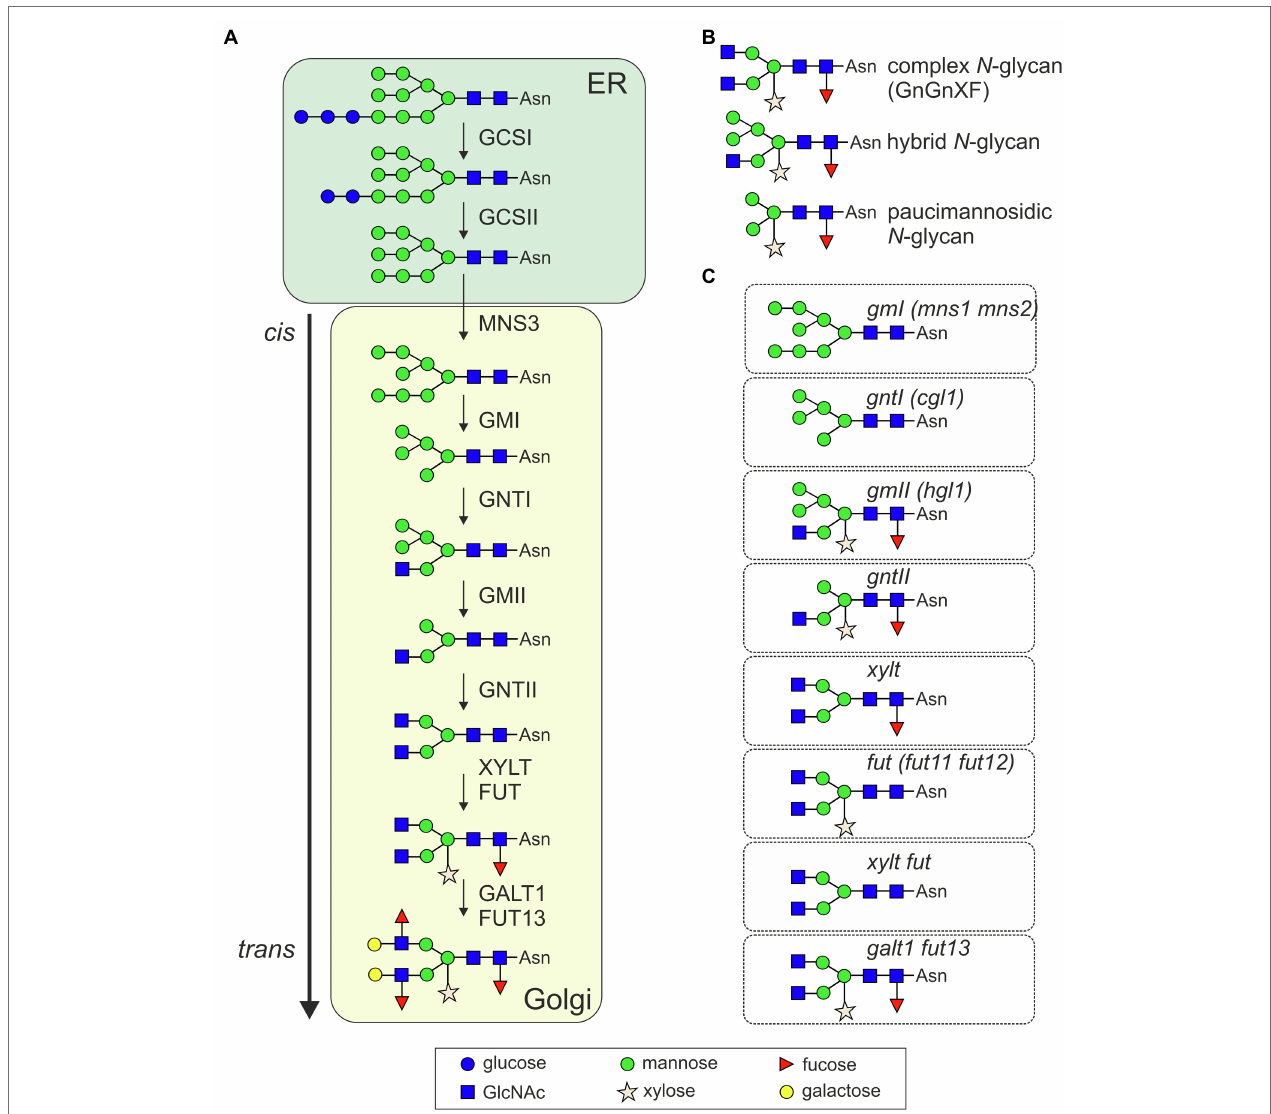
FIGURE 1 | (A) Illustration of the processing pathway for the formation of complex N -glycans in plants. GCSI, α -glucosidases I (GCSI); GCSII, α -glucosidases II; MNS3, ER α -mannosidase; GMI, Golgi α -mannosidase I (two forms termed MNS1 and MNS2 with redundant function are present in Arabidopsis thaliana ); GNTI, β 1,2- N -acetylglucosaminyltransferase I; GMII, Golgi α -mannosidase II; GNTII, β 1,2- N -acetylglucosaminyltransferase II; XYLT, β 1,2-xylosyltransferase; FUT, core α 1,3- fucosyltransferases (two forms termed FUT11 and FUT12 with redundant function are present in A. thaliana ); GALT1, Lewis type β 1,3-galactosyltransferase; and FUT13, α 1,4-fucosyltransferase. Not shown: the removal of terminal GlcNAc residues by β -hexosaminidases, which generates paucimannosidic N -glycans in post- Golgi compartments, at the plasma membrane or in the extracellular space. (B) Illustration of typical complex, hybrid, and paucimannosidic N -glycans. (C) Illustration of the predominate N -glycan structure of the indicated knockout mutants. Alternative names of the mutants are given in brackets. Symbols are used according to the suggestions from the Consortium for Functional Glycomics